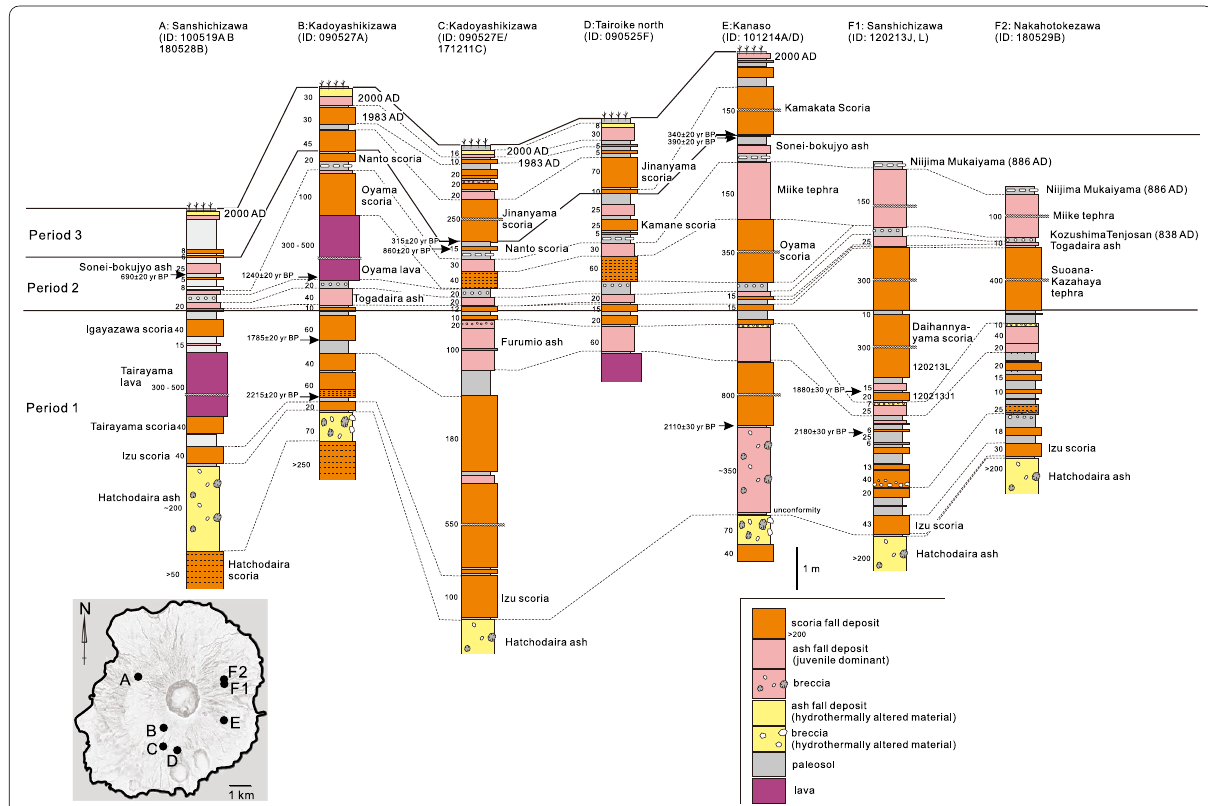
Fig. 5 Stratigraphy of representative outcrops. A Tairayama on the northwestern slope, B Kadoyashikizawa on the southwestern slope, C Tatsunezawa on the southwestern slope, D Tairoike north on the southern slope, E Kanaso–minami on the eastern slope, F1: Sanshichizawa on the eastern slope, F2: Nakahotokezawa on the eastern slope. The unit of the thickness is in